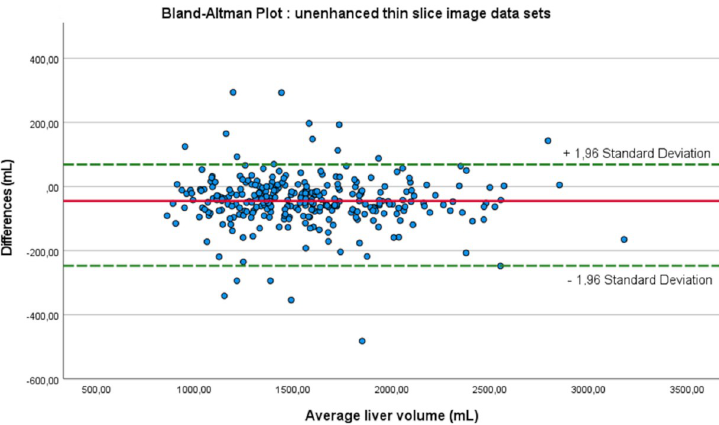
Fig 5. Correlation between manual and automated liver segmentation for unenhanced image data